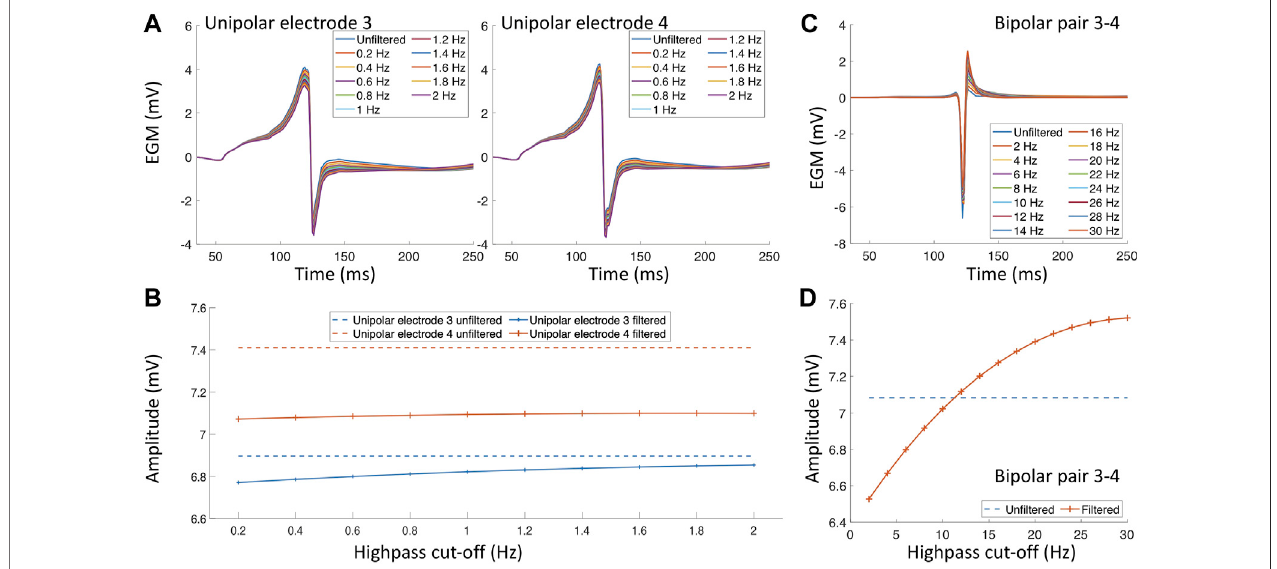
FIGURE 3 | Filter effects on electrograms measured in healthy myocardium. (A) Unipolar electrograms with different highpass fi lter values. (B) Effect of different highpass cut-off values on the unipolar electrogram amplitude. (C) Bipolar electrogram with different highpass cut-off values. (D) Effect of different highpass cut-off values on the bipolar electrogram